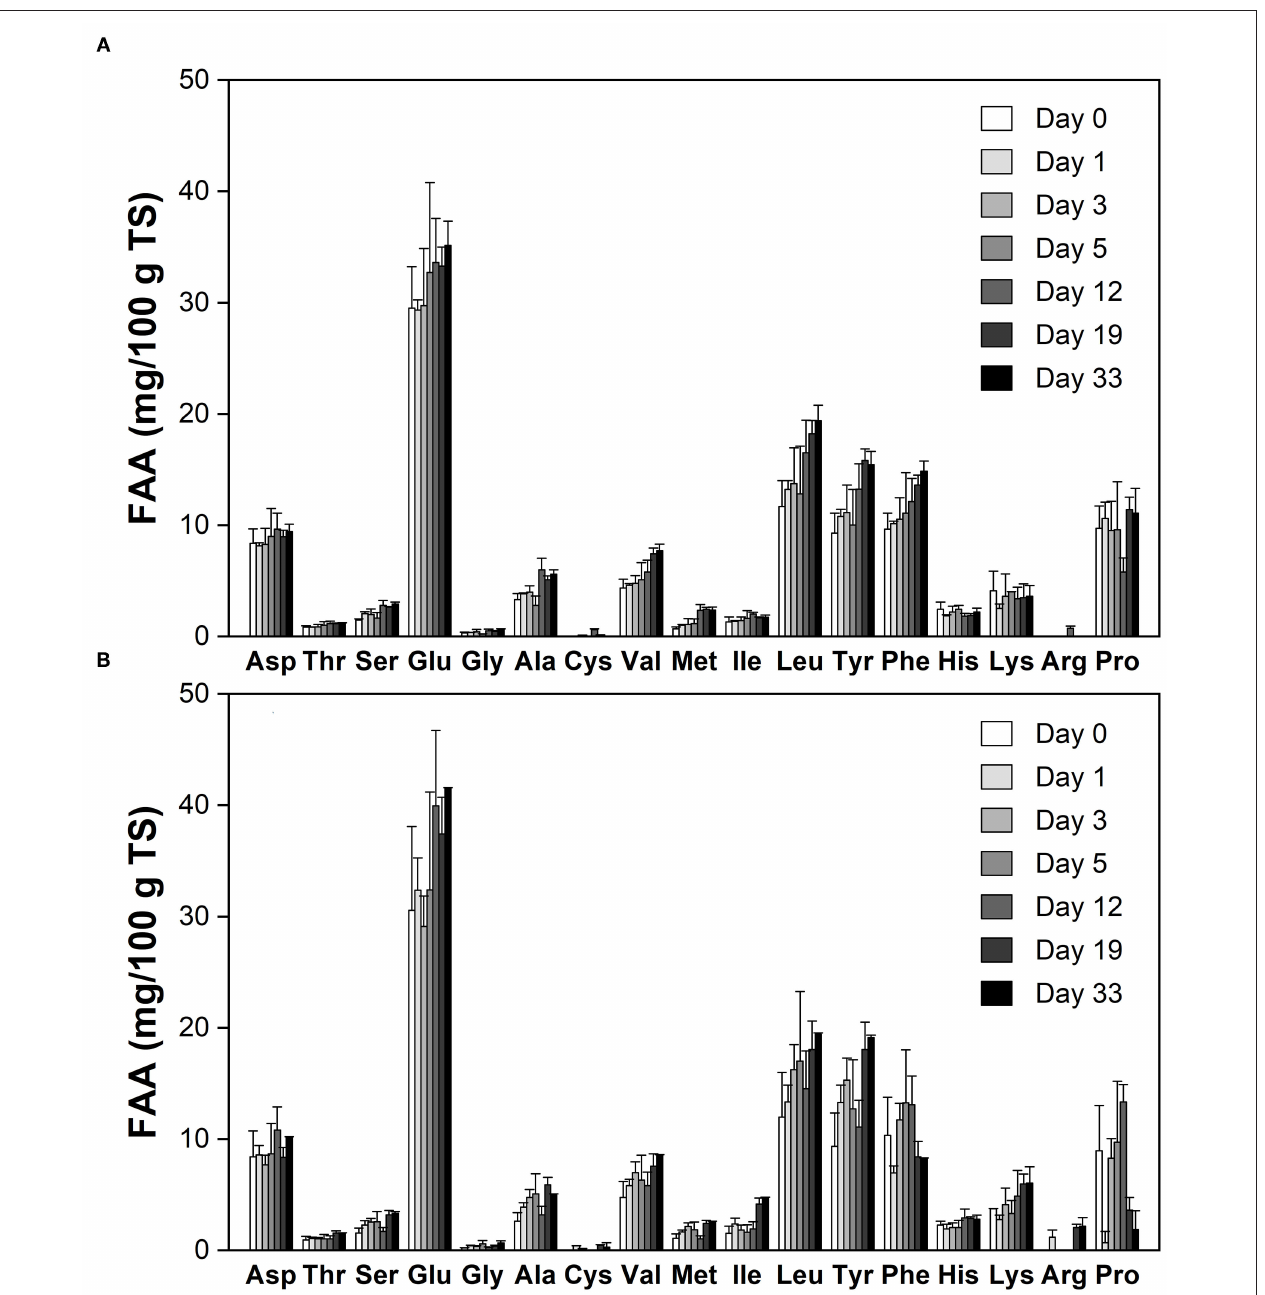
FIGURE 2 | Free amino acid (FAA) profiles during cheese ripening. (A) The control without inoculation of red koji powder; (B) Red-Veined Cheese. Error bars indicate standard deviations from the mean.